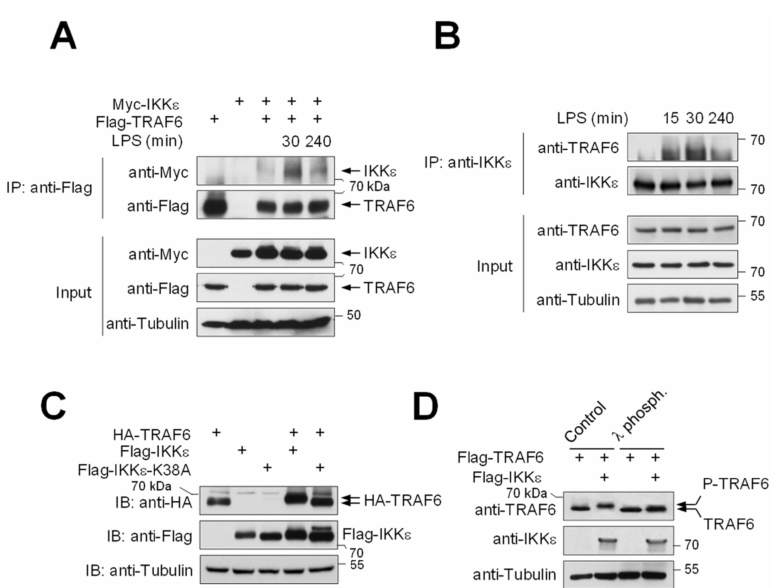
Figure 1. LPS-inducible interaction between IKK ε and TRAF6. ( A ) HEK293 cells stably expressing TLR4 (293 TLR4) were transfected to express Myc-IKK ε either alone or along with Flag-TRAF6. Cells were treated with LPS (2 µ g/mL) for the indicated periods and lysed under native conditions. One aliquot of the extract was used for the input control; the remaining material was used for immunoprecipitation with anti-Flag antibodies. After elution of bound proteins, coprecipitated IKK ε was visualized by Western blotting with anti-Myc antibodies. ( B ) HEK293 TLR4 cells were stimulated with LPS, as shown, and one aliquot of each cell extract was used for co-immunoprecipitation using anti-IKK ε antibodies. ( C ) HEK 293 cells were transfected to express HA-TRAF6 alone or together with Flag-IKK ε or Flag-IKK ε -K38A, as shown. Cells were lysed under denaturing conditions, TRAF6 and the slower migrating form were detected by Western blotting using anti-HA antibodies. ( D ) HEK293 cells transfected to express Flag-TRAF6, alone or together with Flag-IKK ε , were lysed under native conditions and incubated with λ -phosphatase for 20 min. TRAF6 and its phosphorylated form were detected by Western blotting with anti-TRAF6